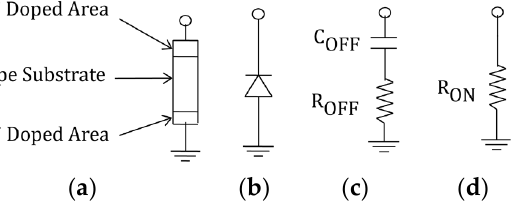
Figure 9. ( a ) Integrated junctions. ( b ) Diode. ( c ) OFF-state ideal model. ( d ) ON-state ideal model.